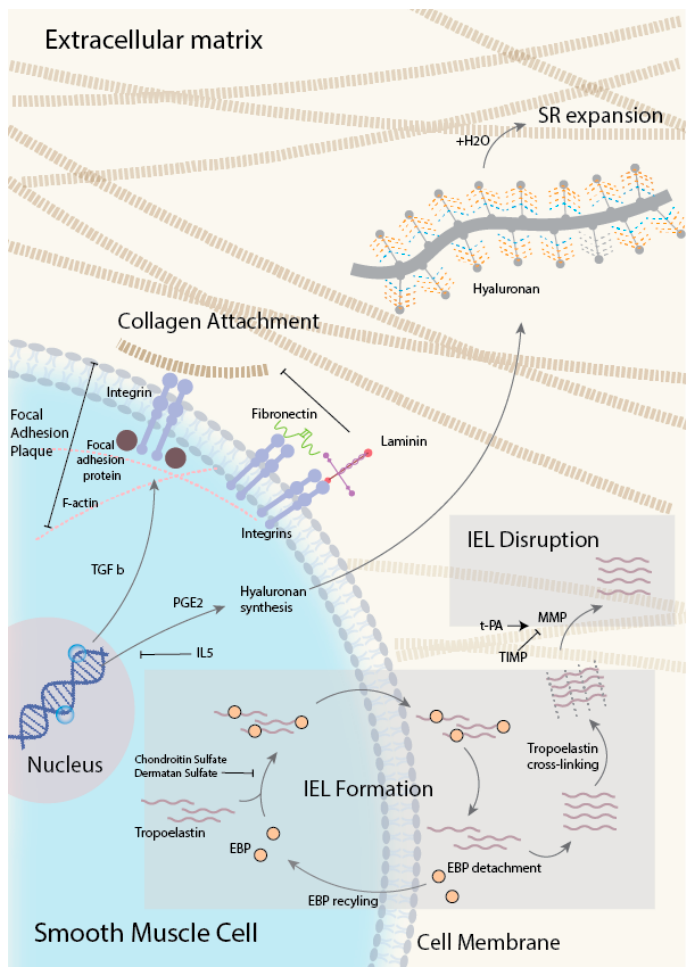
Figure 3. A conceptual overview of the role of ECM in DA. Integrin acts as an adhesive to the ECM matrix and promotes the migration of SMC into ECM through adhesion. Hyaluronan promotes H2O influx into the subendothelial region (SR) of which causes the region to loosen and expand and promote SMC migration. Degradation of tropoelastin crosslink IEL reduces the barrier integrity and allows SMC to migrate through and into the SR. MMP: matrix metalloproteinase, TIMP: tissue inhibitors of metalloproteinase, t-PA: tissue-type plasminogen activator, EBP: Elastin binding protein.